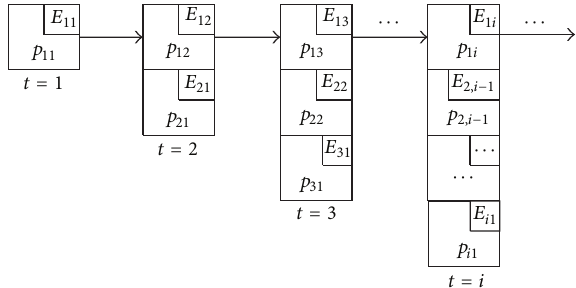
+ 𝐸 + 𝐸 31 22 13 . Figure 2: The probabilities that each part of the lurkers becomes spreaders; 𝑝 𝑗ℎ represents the probability that lurkers 𝐸 𝑗ℎ become